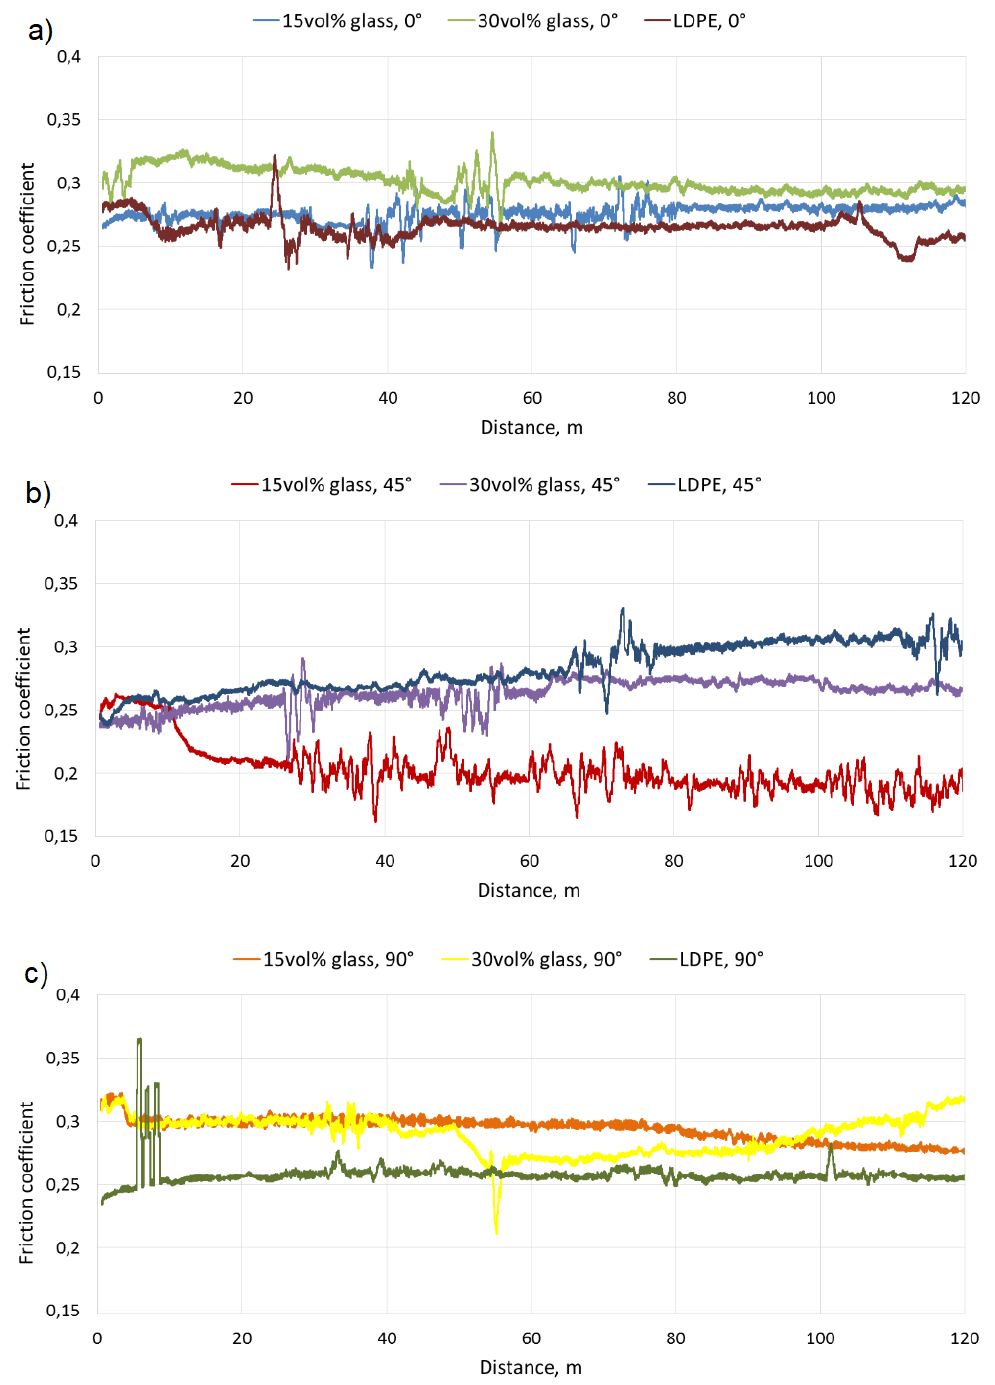
Figure 9. Representative curves of changes of the friction coefficient determined for neat LDPE and for composites over a distance of 120 m, rotated relative to the friction direction by: a ) 0°, b ) 45°, c ) 90°.